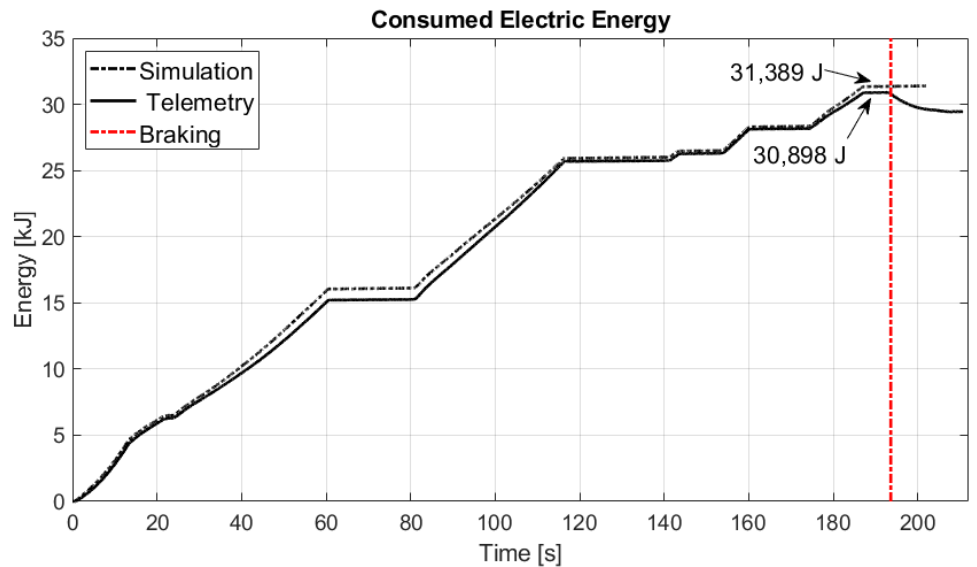
Figure 8. Comparison the simulated and recorded energy consumption for model validation.